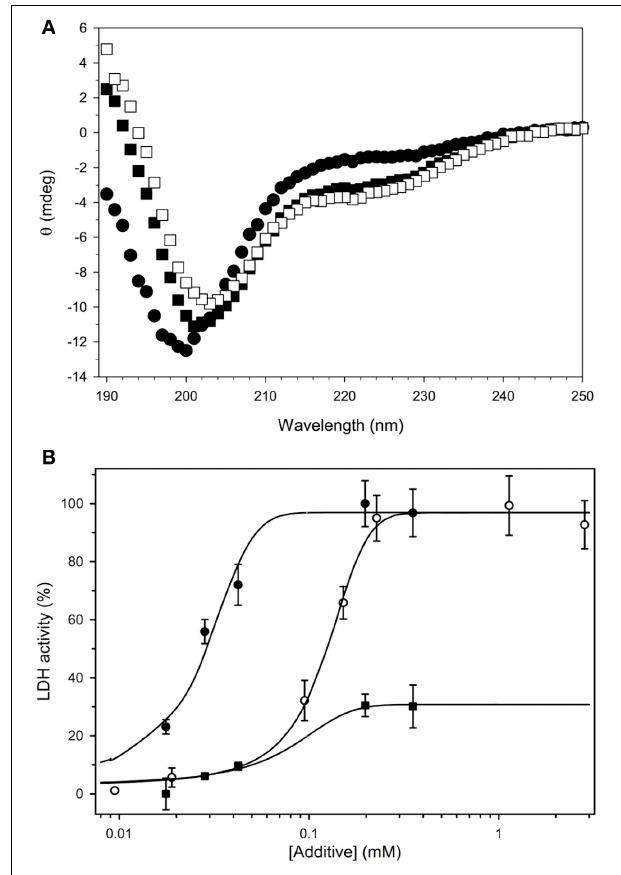
FIGURE 5 | Biochemical characterization of recombinant OpsDHN1. (A) The secondary structure content of OpsDHN1 was determined under several conditions. OpsDHN1 alone, filled circles; OpsDHN1 in the presence of 50mM SDS, filled squares; OpsDHN1 in the presence of 50mM SDS and 1mM ZnCl 2 , open squares. (B) Cryoprotection assay with OpsDHN1. The protection of LDH from freeze-thaw damage was assessed as described in the Materials and Methods. OpsDHN1, filled circles; Vitis riparia K 2 , open circles; FROST protein, filled